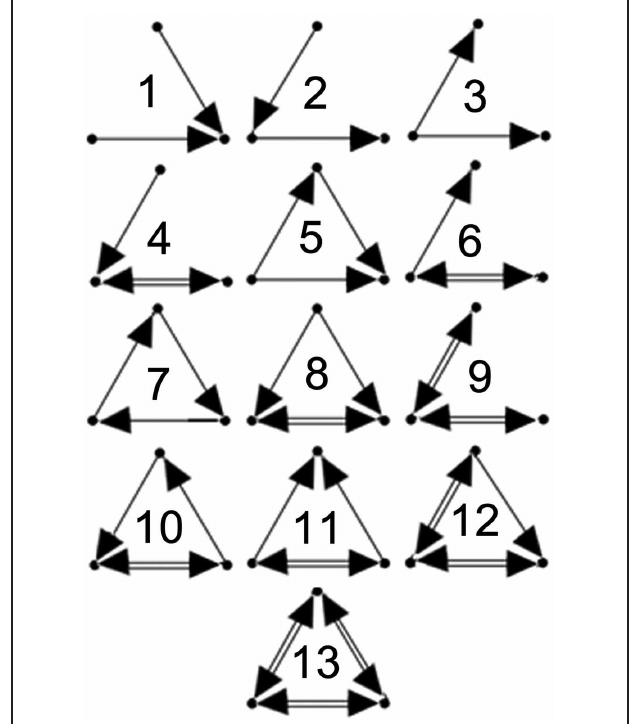
FIGURE 1 | Triad types. Configurations of the 13 possible unique 3-neuron subgraphs (triad types). Numbering scheme taken from Sporns and Kotter